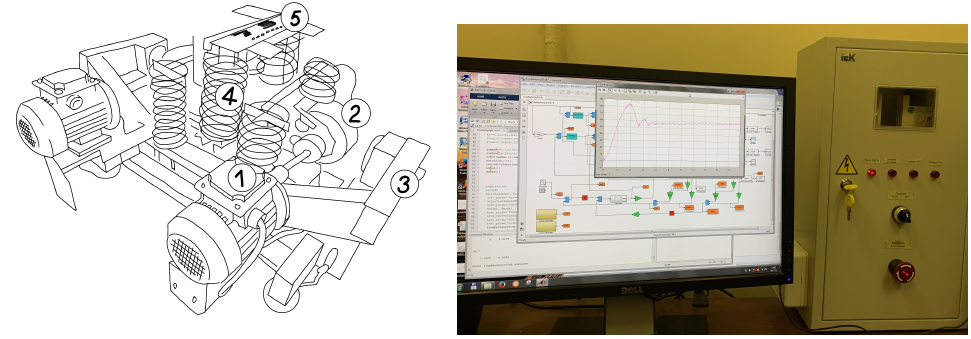
Figure 1. Axonometric view of mechanical part ( left ) and control board photo ( right ) of laboratory mechatronic setup MMLS